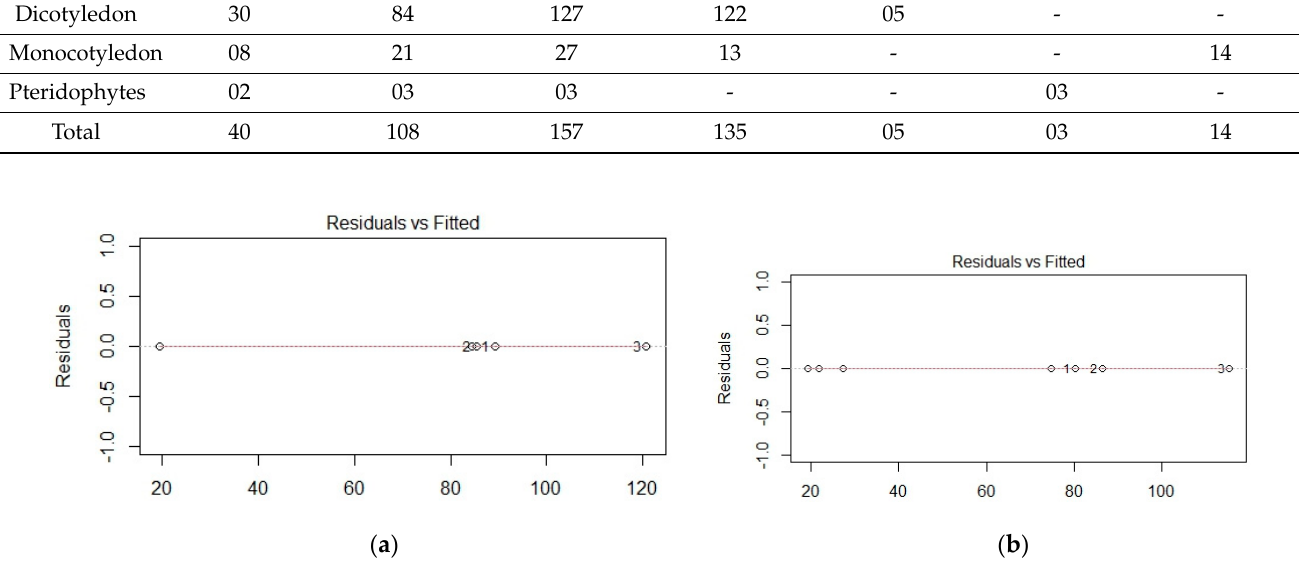
Figure 2. Linear modeling between soil parameters and density of plants: ( a ) disturbed sites and ( b ) undisturbed sites.